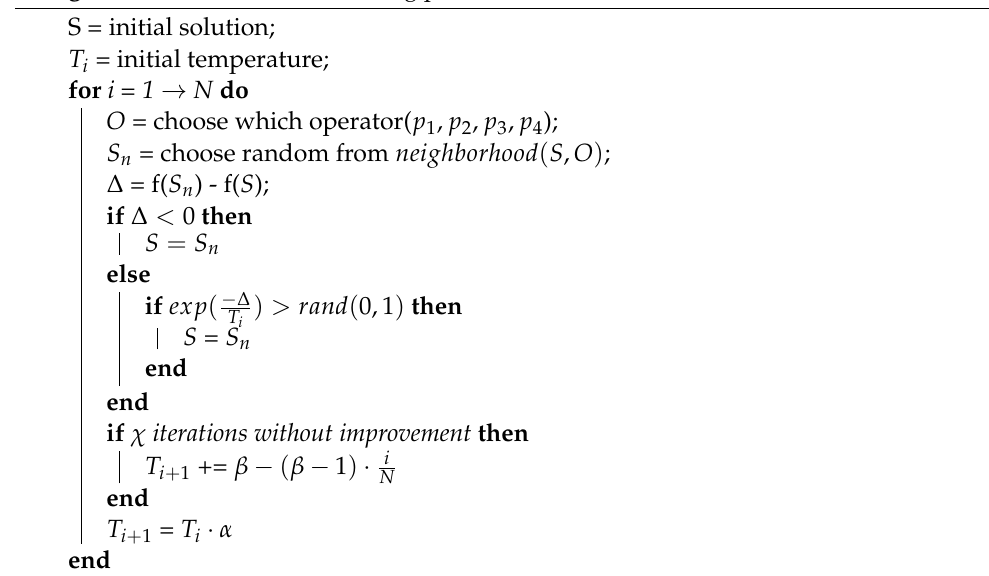
Algorithm 1: Simulated annealing procedure